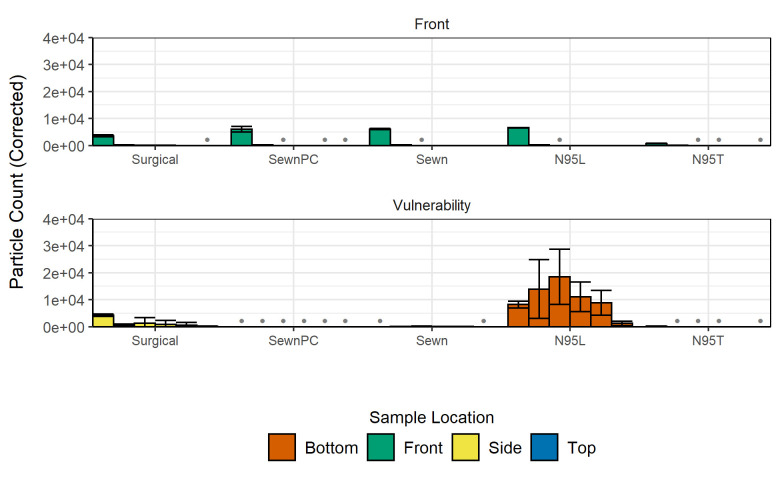
Background-corrected particle counts comparing Front and vulnerable positions for each facemask at a one-foot (0.3 m) distance in the open bench environment.Measurements shown are grouped by particle size bin and colored by measurement position. Row 1 includes particle counts for the Front position of each facemask. Row 2 includes vulnerable positions deemed significant during experimental observation. Vulnerable positions include: Side (Surgical mask), Bottom (N95L), and Top (sewn masks, N95T). Gray bullet points at the baseline indicate negative background-corrected counts. Error bars indicate the sample standard deviation for particle counts in each of the respective particle size bins from three independent measurements. For statistical analyses, refer to the open bench analysis described in Fig 4.